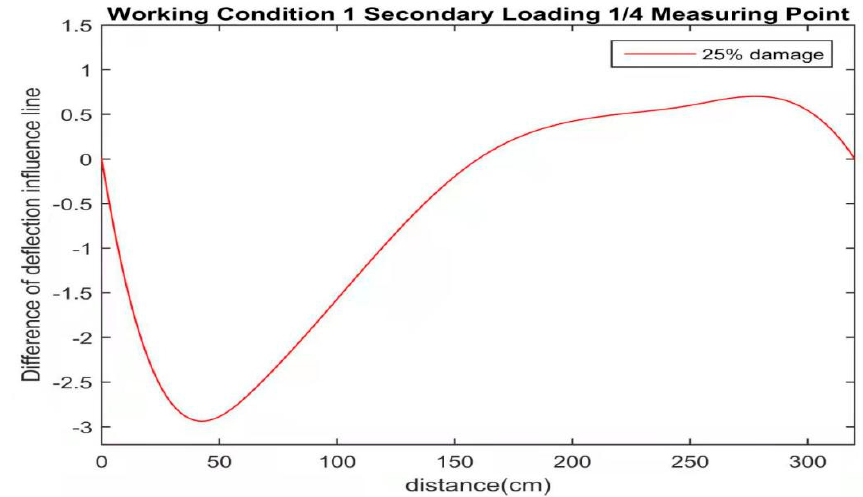
Figure 33. The deflection influence line difference of the first span 25/100 determining point in work condition 4.